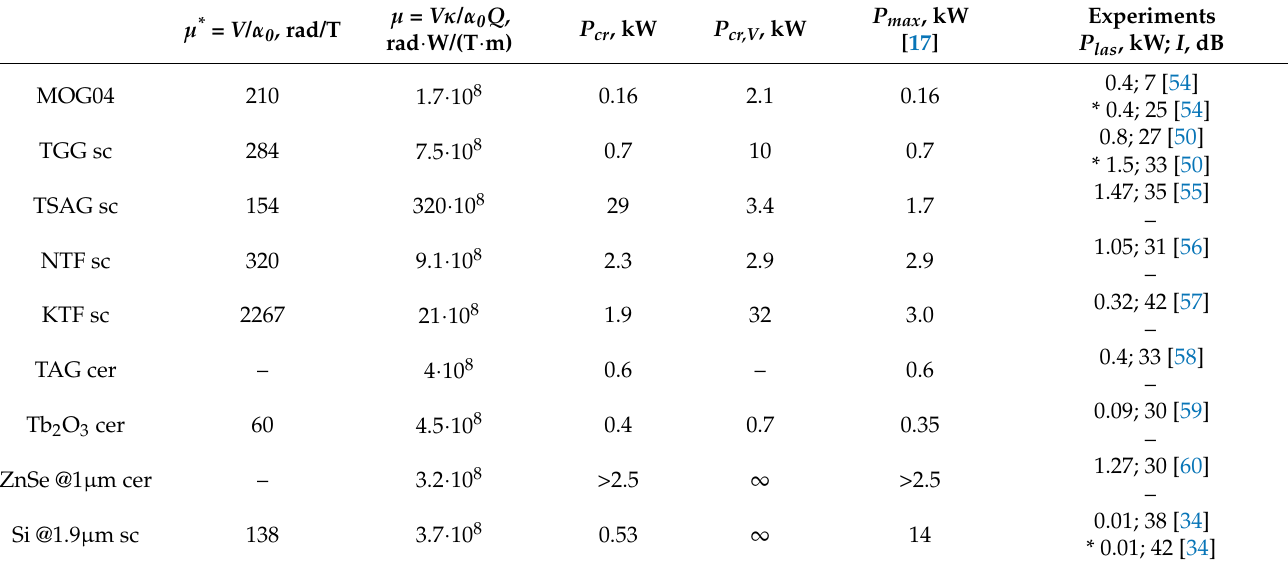
Table 1. FoM for MO materials with known thermo-optical